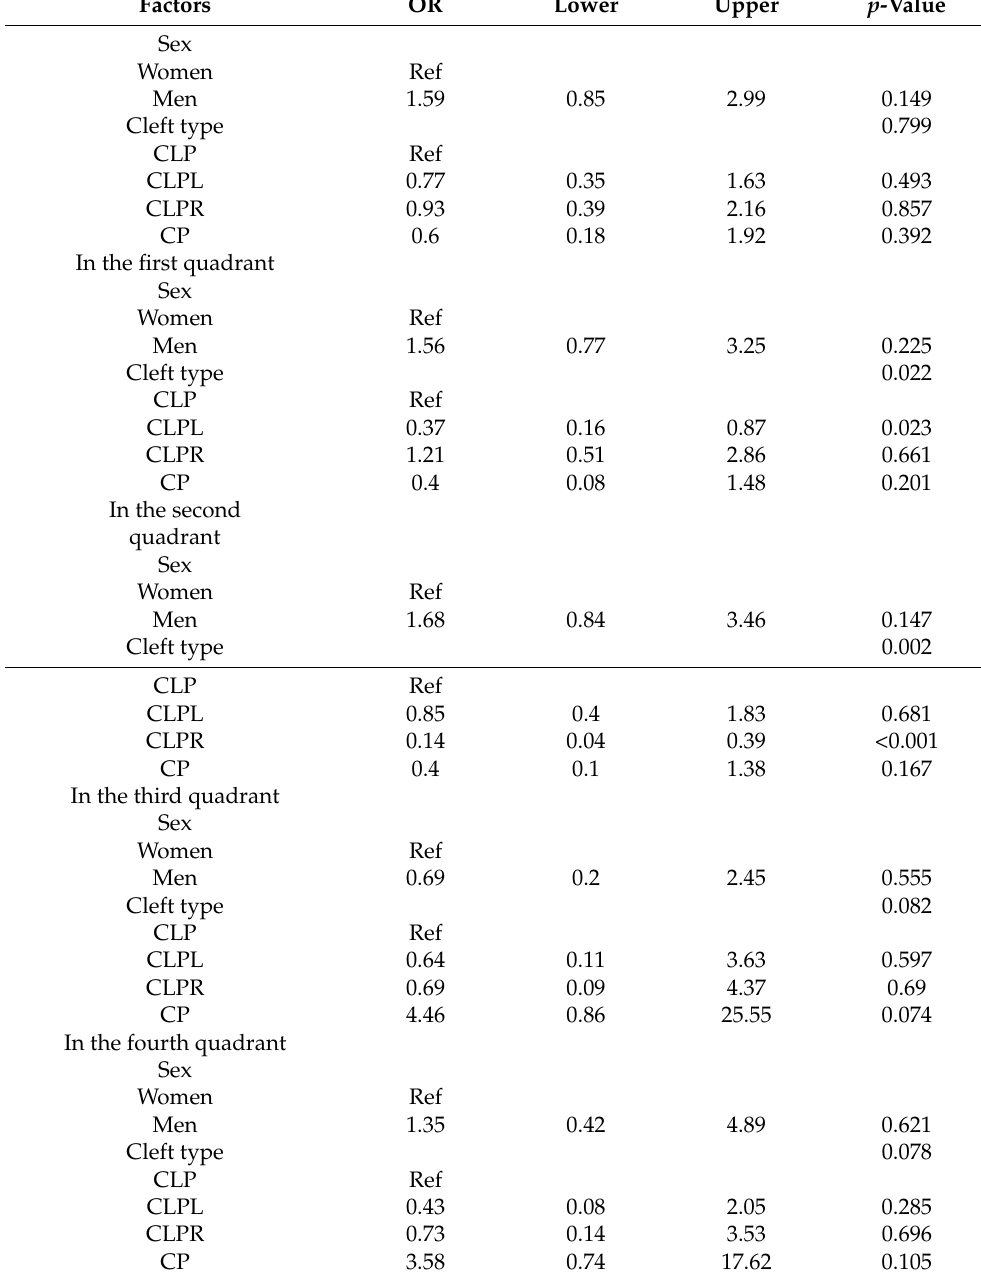
Table 5. Odds ratios (95% CI and p) for the association of tooth agenesis (at least one tooth being missing) with gender and cleft type. Tooth agenesis was evaluated in the whole mouth and within each quadrant.